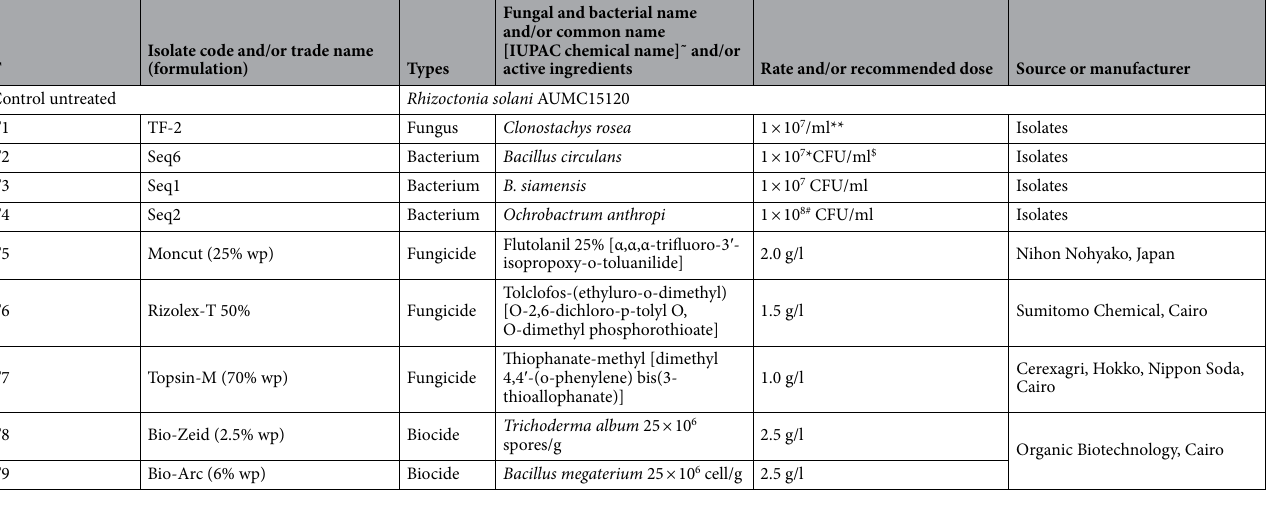
Table 2. Fungal and bacterial bioagents, fungicides, and biocides, used in the present study against Rhizoctonia solani , with their trade name, formulation, common and chemical name, recommended dose, and their sources. T = treatments, **conidia spores/ml 47 , * 48 , $ = serial dilutions cell (CFU/ml) namely colony- forming units ml −1 , #49 , ˜IUPAC = International Union for Pure and Applied